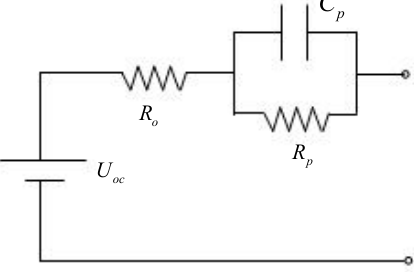
Figure 4. Schematic of the Thevenin model.